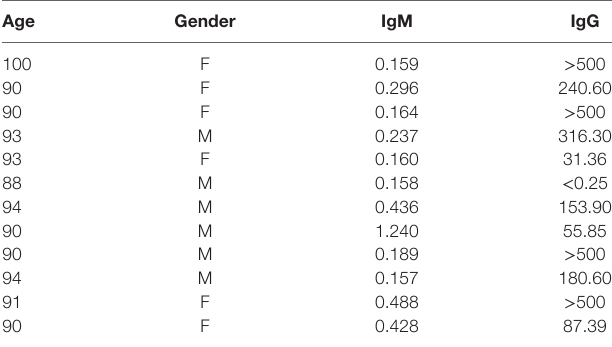
Table 2 | Serum levels of IgM and IgG to cytomegalovirus in old (80–100 years)